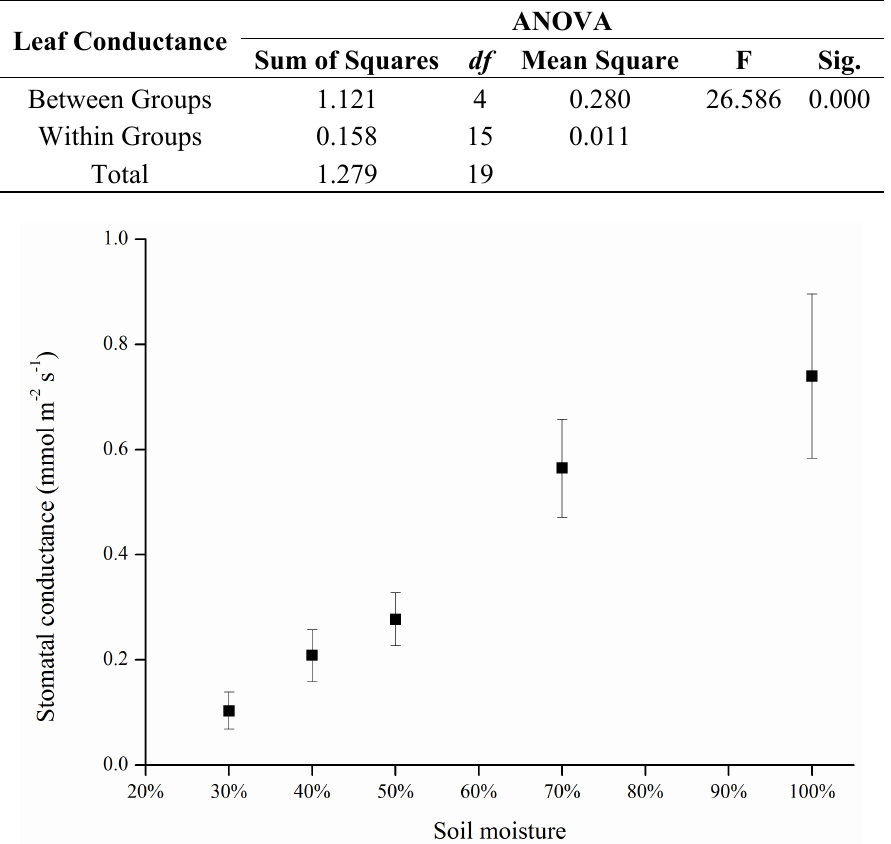
Table 3. Analysis of the differences in canopy stomatal conductance within and between treatments.